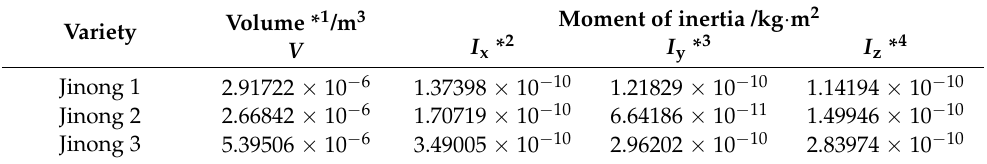
Table 12. Generation of particle parameters by simulation.